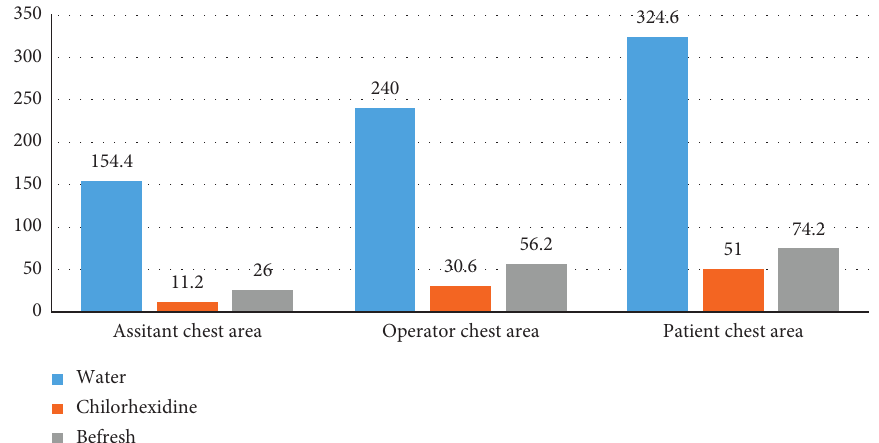
Figure 2: CFU (Colony Forming Unit) among three groups in different locations during the ultrasonic scaling procedure. Table 2: Mean CFU/plate according to treatment and locations during the procedure.